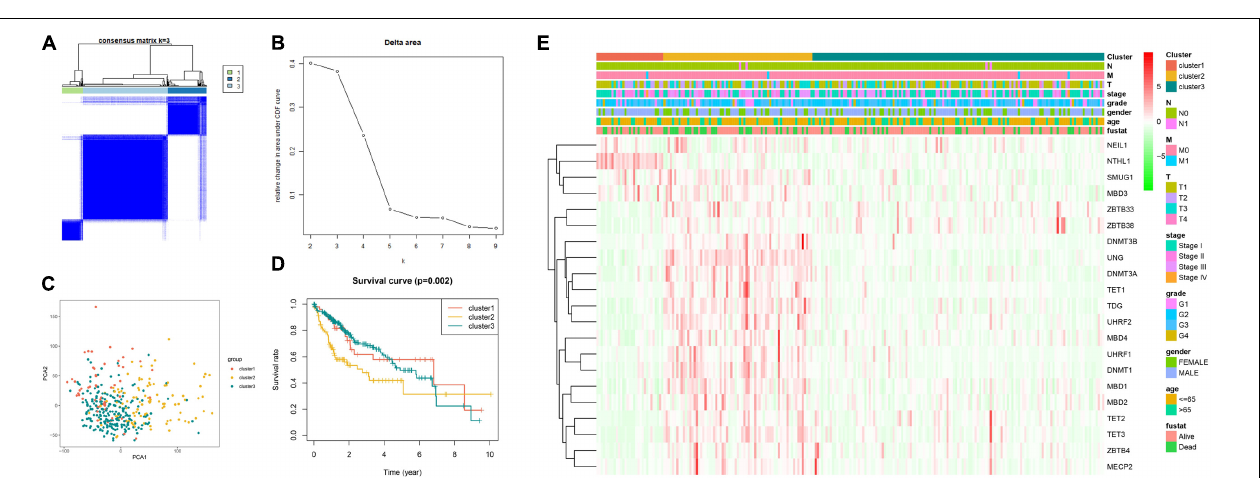
gene ( NTHL1 ) and other genes ( ZBTB33 , ZBTB38 , TET2 , ZBTB4 , DNMT3A , TDG , UHRF2 , TET3 ). Based on